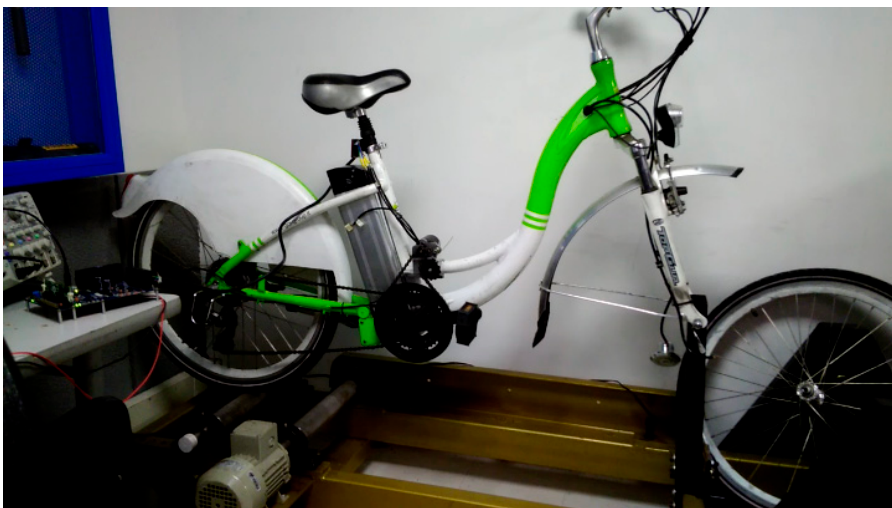
Figure 17. Test bench for the MTO 5065-170-HA-C motor.